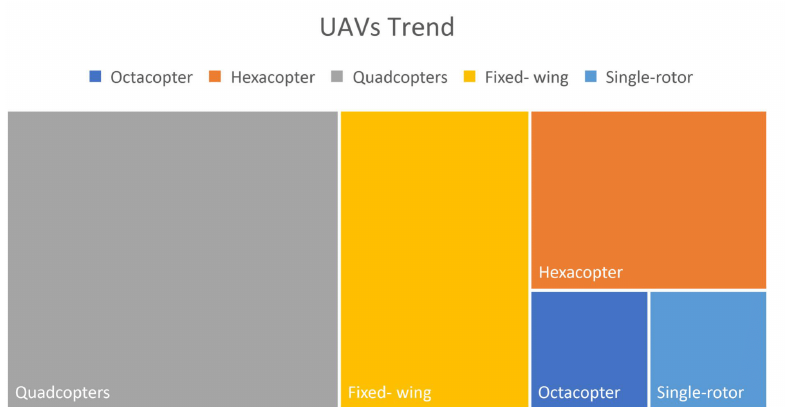
Figure 7. UAV type tree-map based on number of